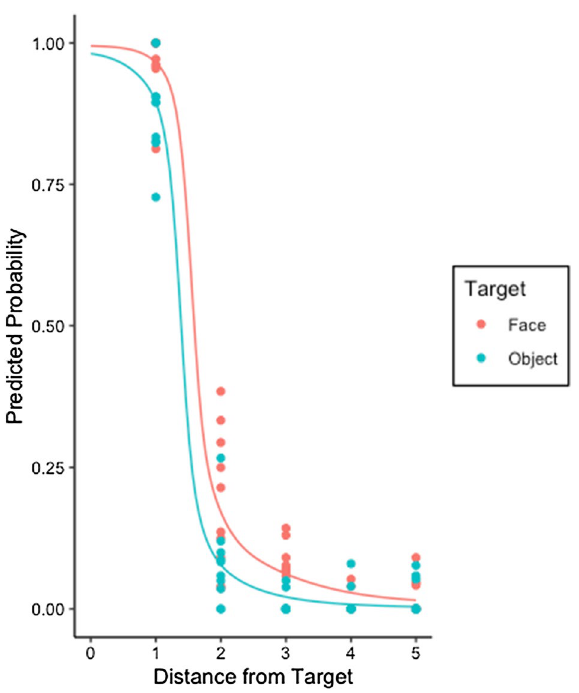
the observed probability for each